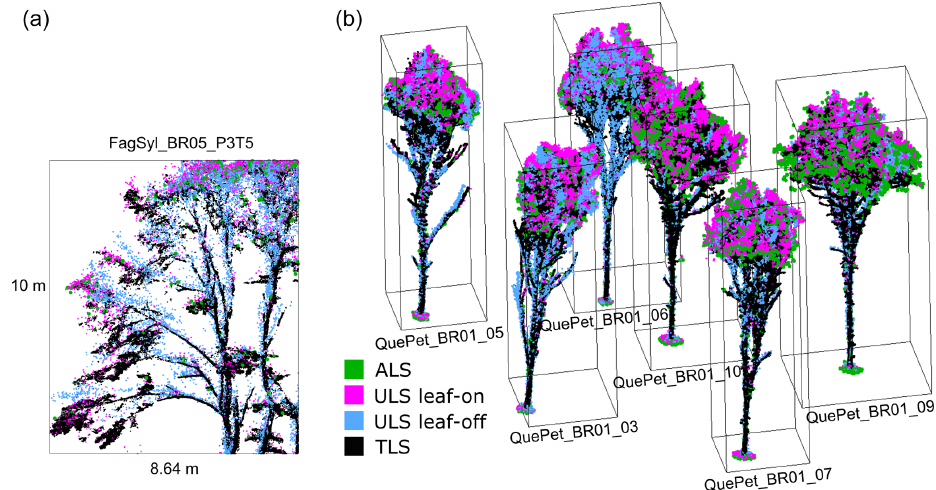
Figure 4. Point cloud visualizations showing the different point density and coverage for each platform. (a) Section of point clouds of a beech tree in plot BR05. The section has a depth of 1m. (b) Point clouds of oaks in plot BR01. The trees are 16 to 18m tall. Point clouds are labeled by their tree ID in the